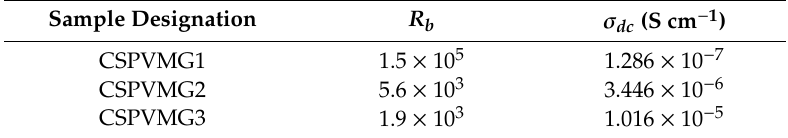
Table3. IonicconductivityofglycerolplasticizedofCS:PVA:Mg(CF 3 SO 3 ) 2 systemsatroomtemperature.